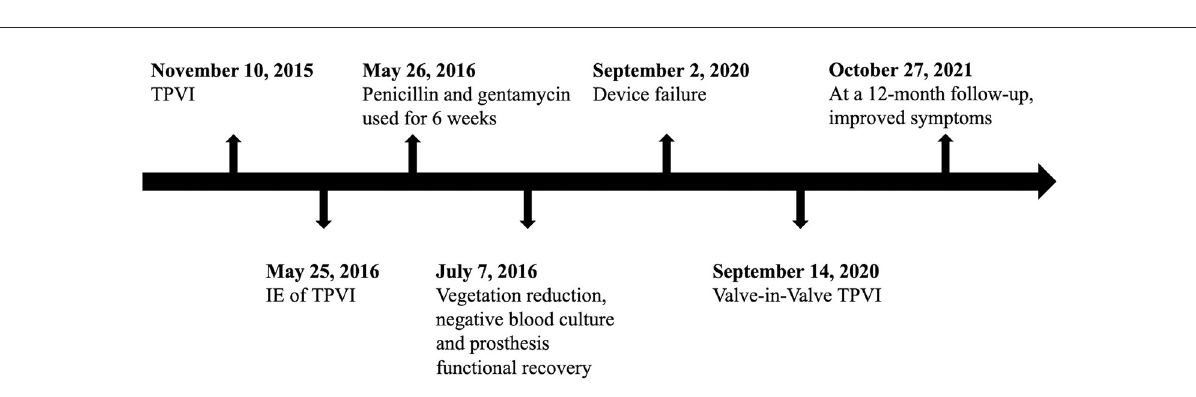
FIGURE3 Timeline of events of the